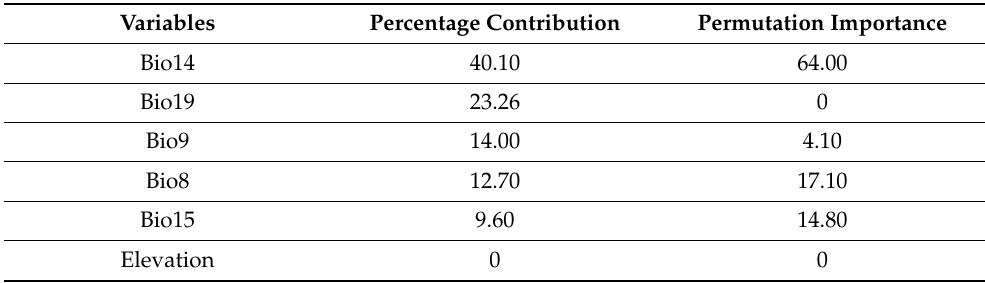
Table 3. Relative contribution of the various bioclimatic variables for Bracon nigricans ecological niche